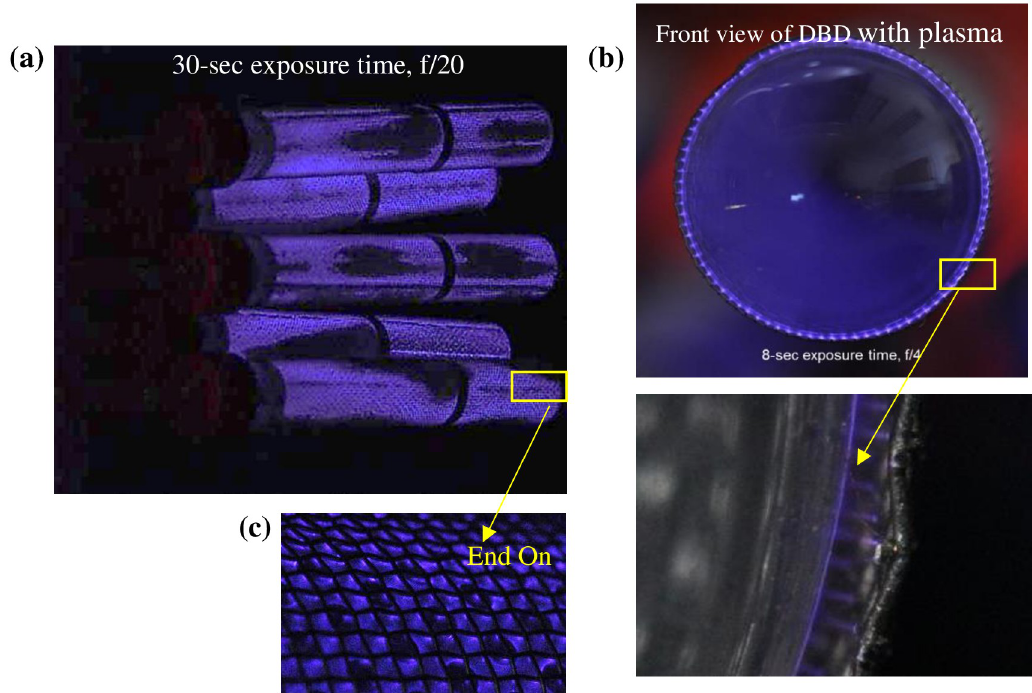
Fig 3. Device configuration of Aerisa 5350: (a) full view of DBD plasma generated on the outer surface of tubes, (b) filamentary discharge at the front side of a DBD tube, and (c) surface microdischarge.